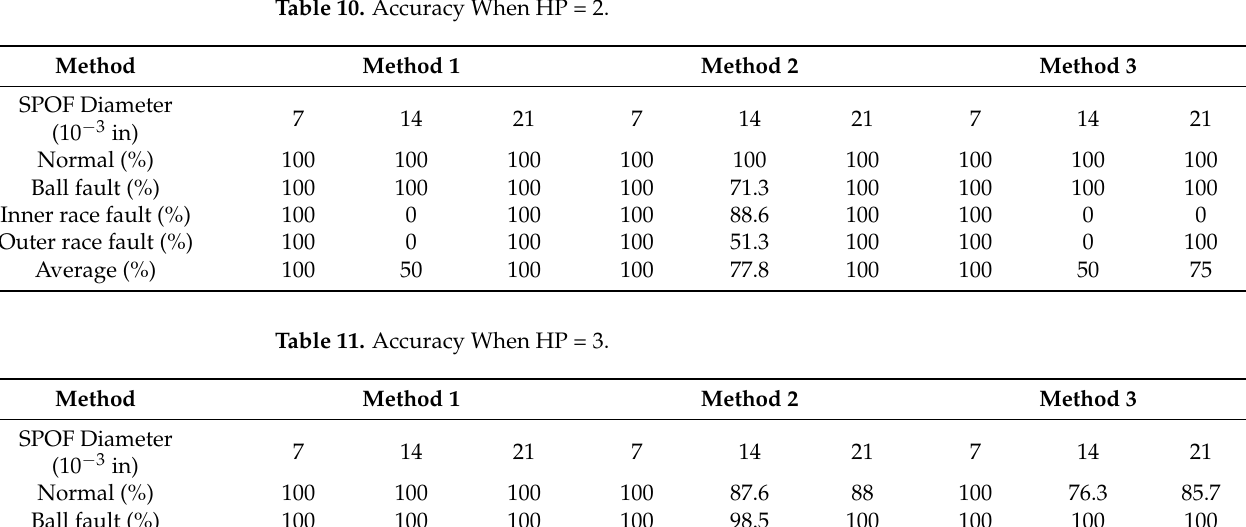
Table 10. Accuracy When HP = 2.